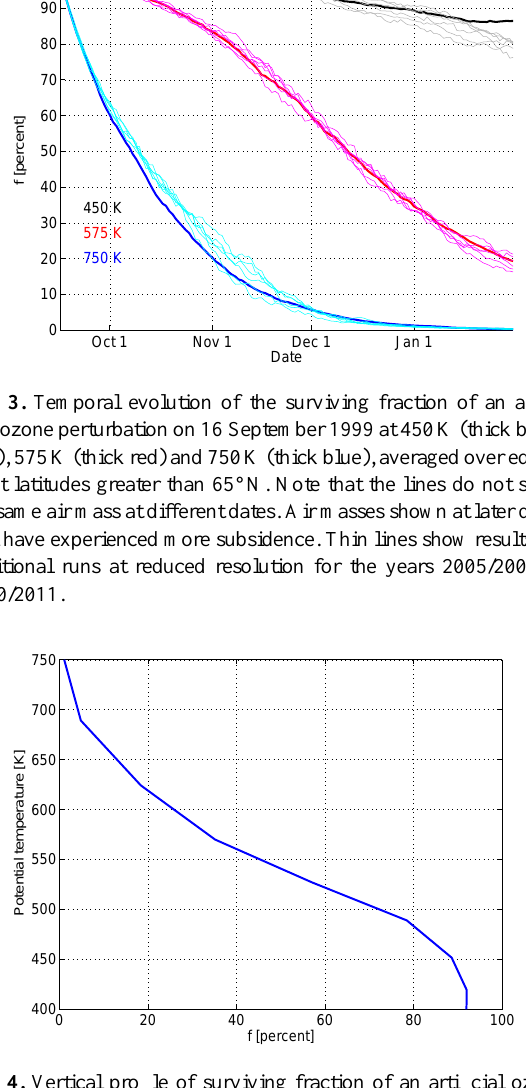
Fig. 4. Vertical profile of surviving fraction of an artificial ozone perturbation on 16 September 1999 on 3 January 2000, averaged over equivalent latitudes greater than